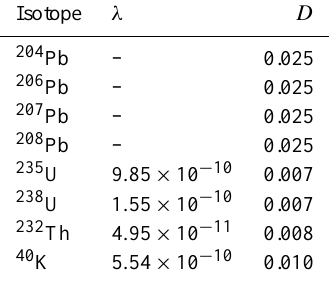
Table 3. Isotope data: decay constant ( λ ) per year and partition co- efficient ( D ) of